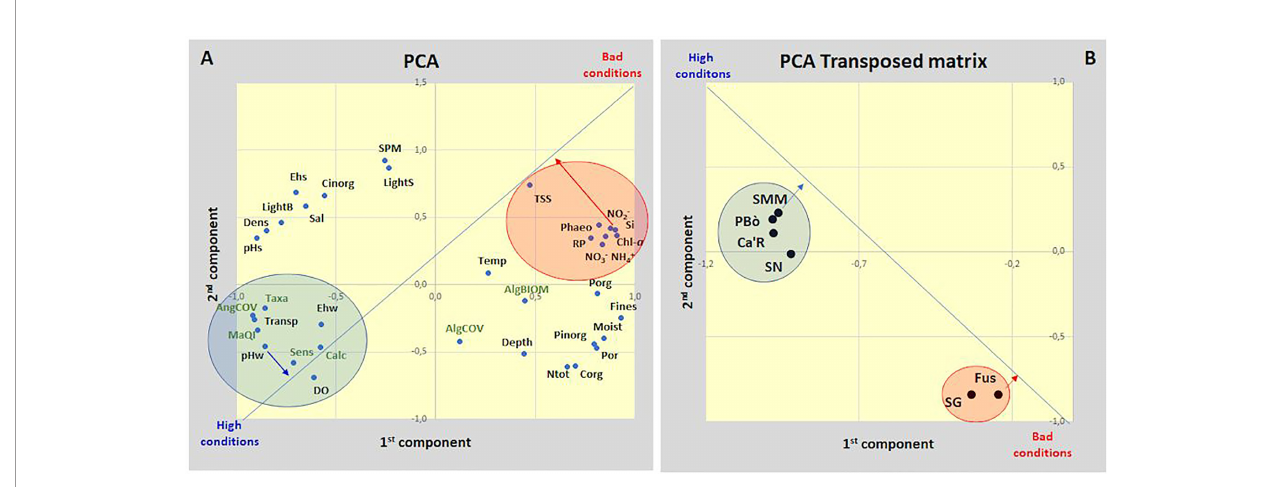
FIGURE 5 | PCA analysis of (A) plot of environmental parameters and macrophyte variables; (B) plot of the 6 stations in the transposed